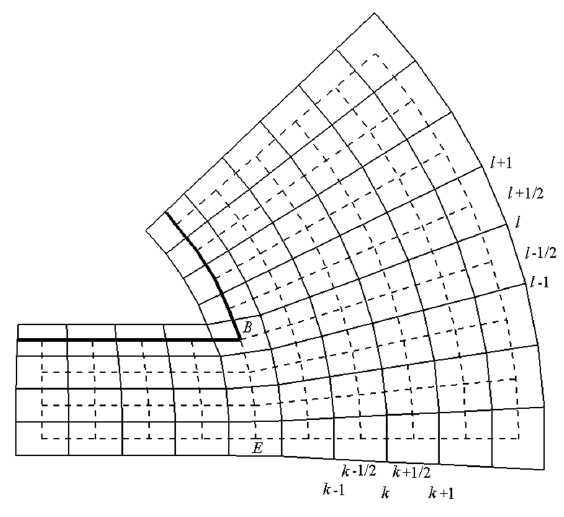
Figure A3. Grid in the channel and in the slot space. The intersections of the dashed lines are the centers of the cells, which are indicated with half-integer indices. The thick lines show the boundaries of the channel and those of the slot space, behind which lawn points (points lying outside the computational domain) are located.